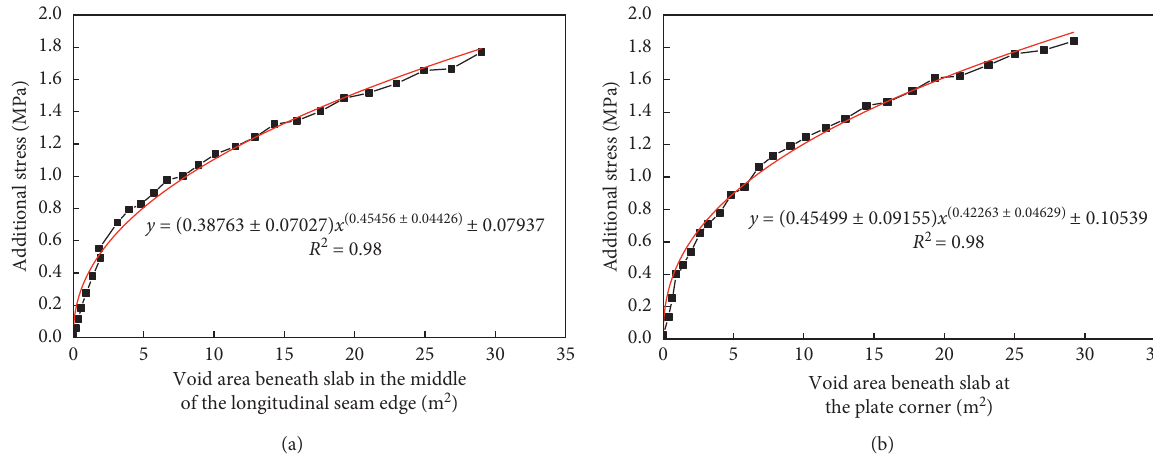
Figure 18: Relationship between the additional flexural stress and void area beneath slab. (a) The middle of longitudinal seam edge. (b) The slab